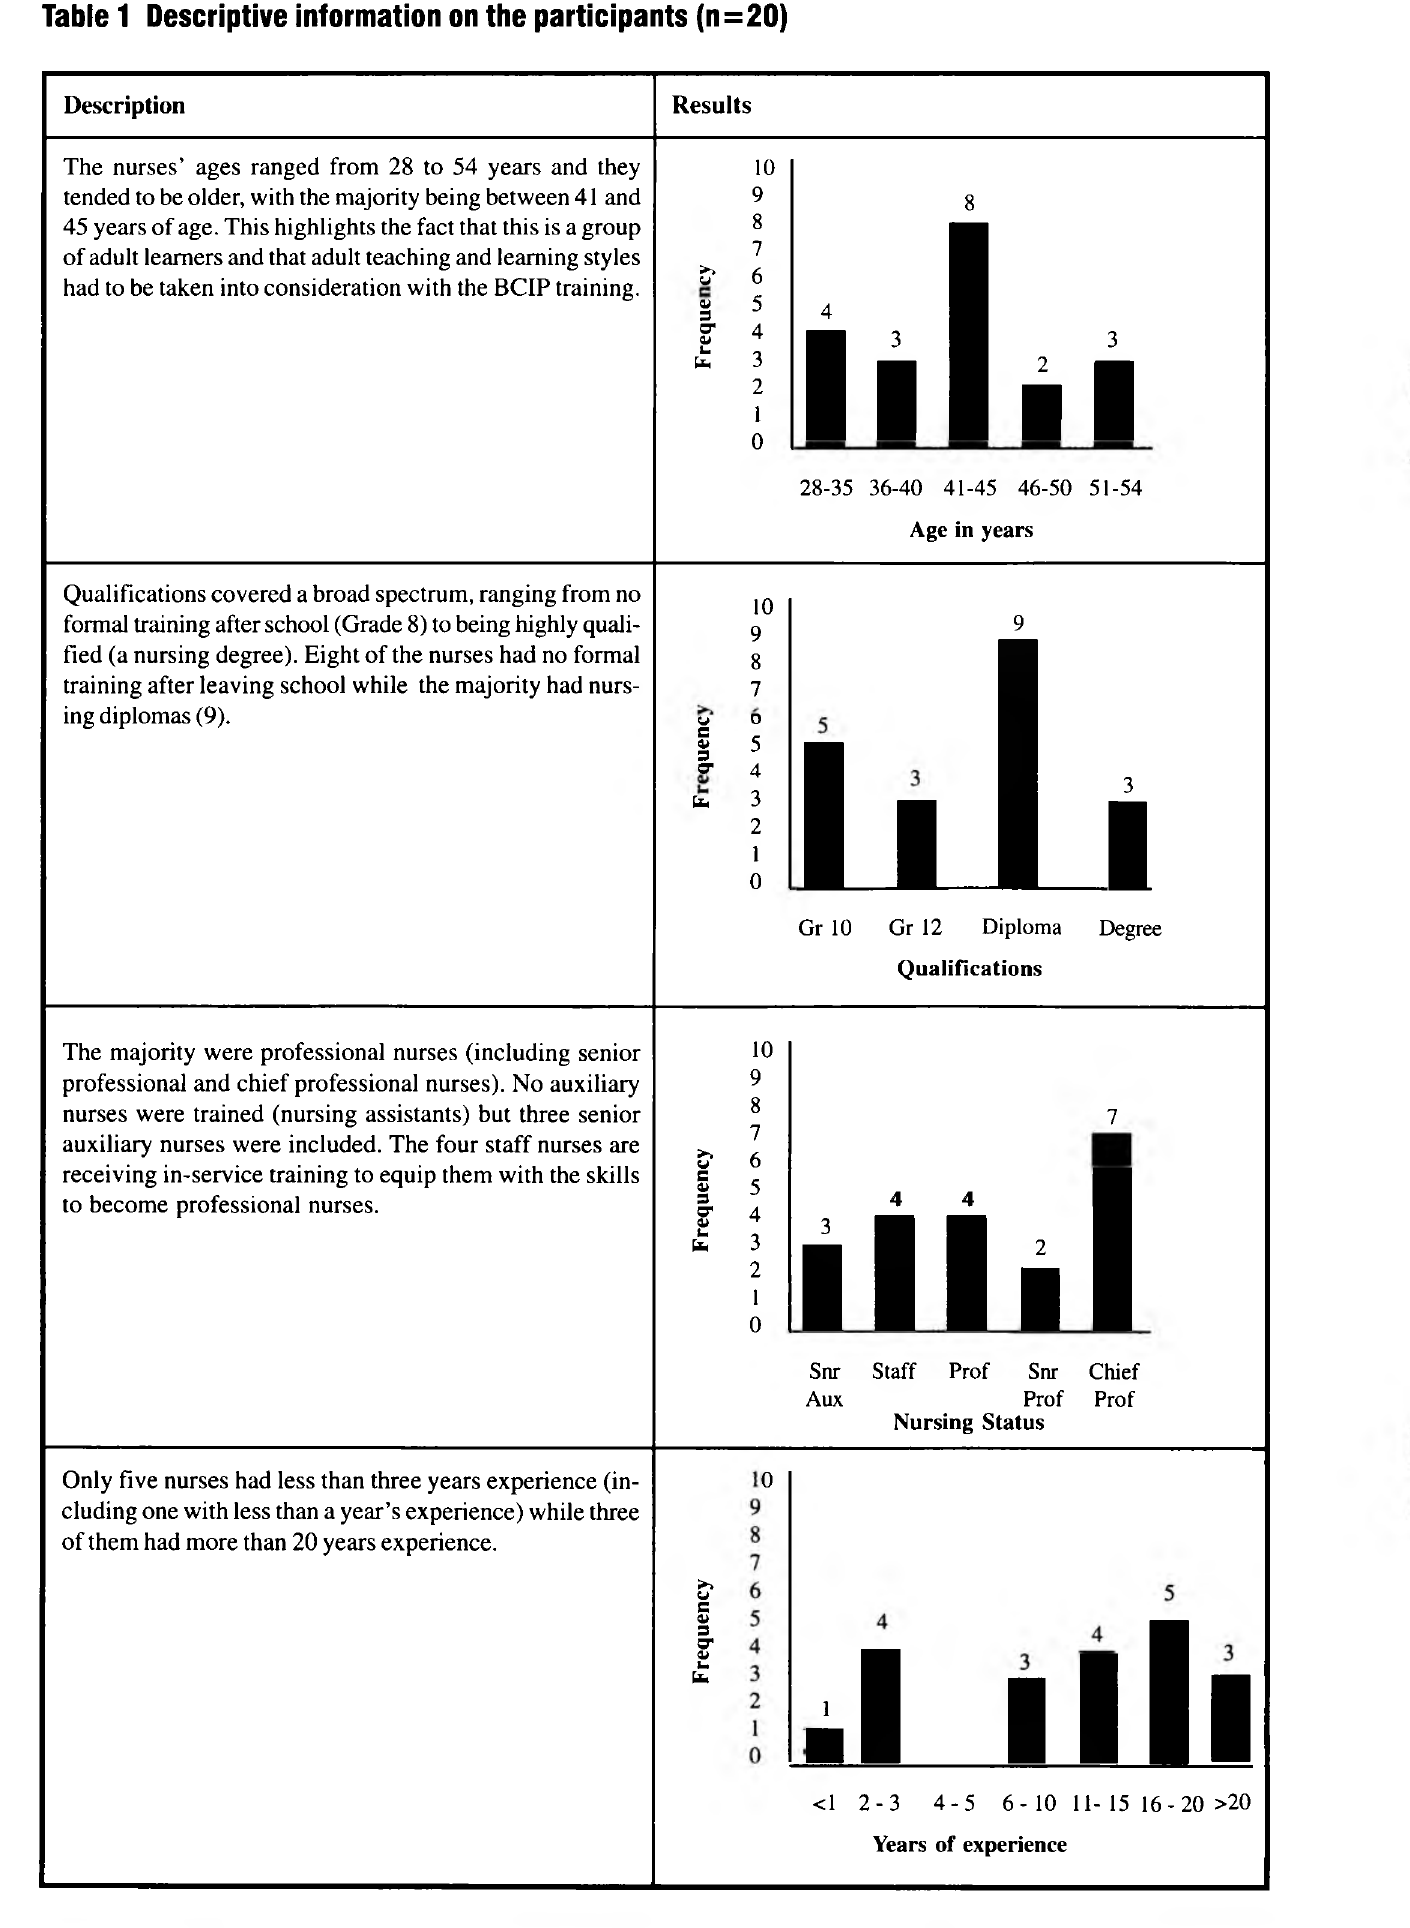
Table 1 Descriptive information on the participants (n=20)